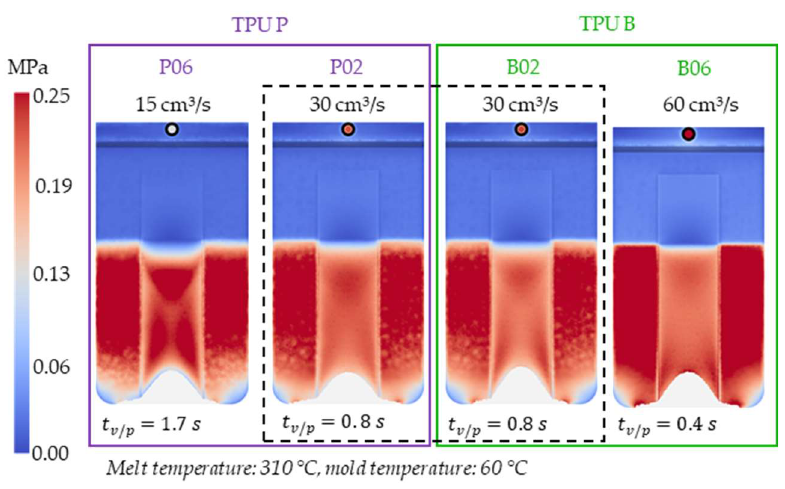
Figure 8. Shaded contour plots of the shear stress at wall result at switchover (t v/p = 99% filled) for the settings with low melt and mold temperature.